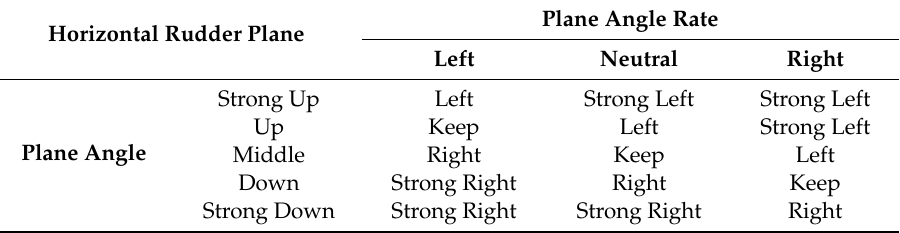
Table 5. Rule base of the horizontal rudder